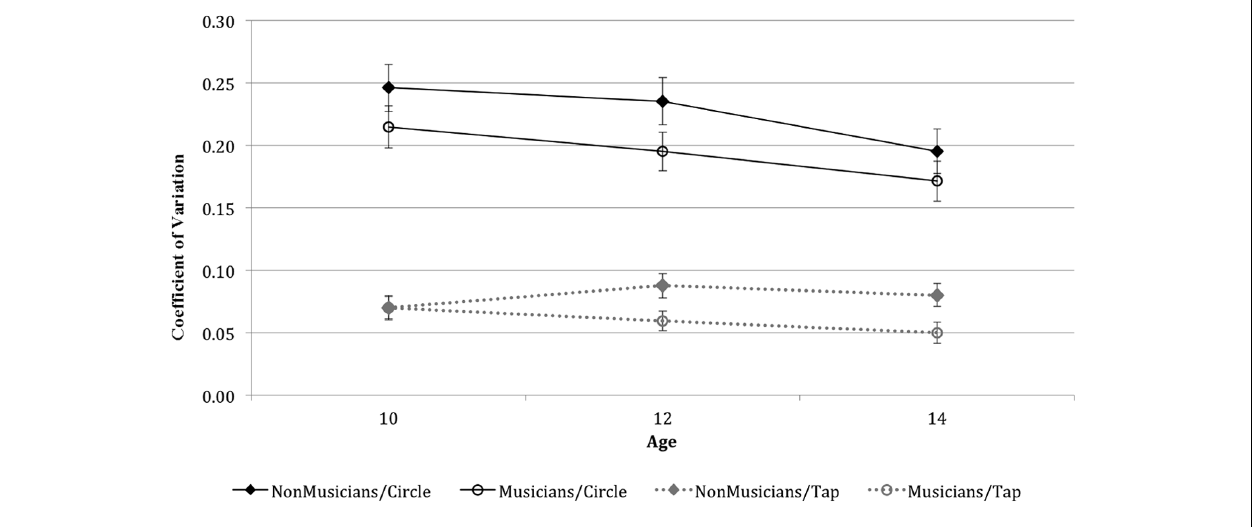
FIGURE 1 | Coefficient ofVariation as a function ofTask,Age and